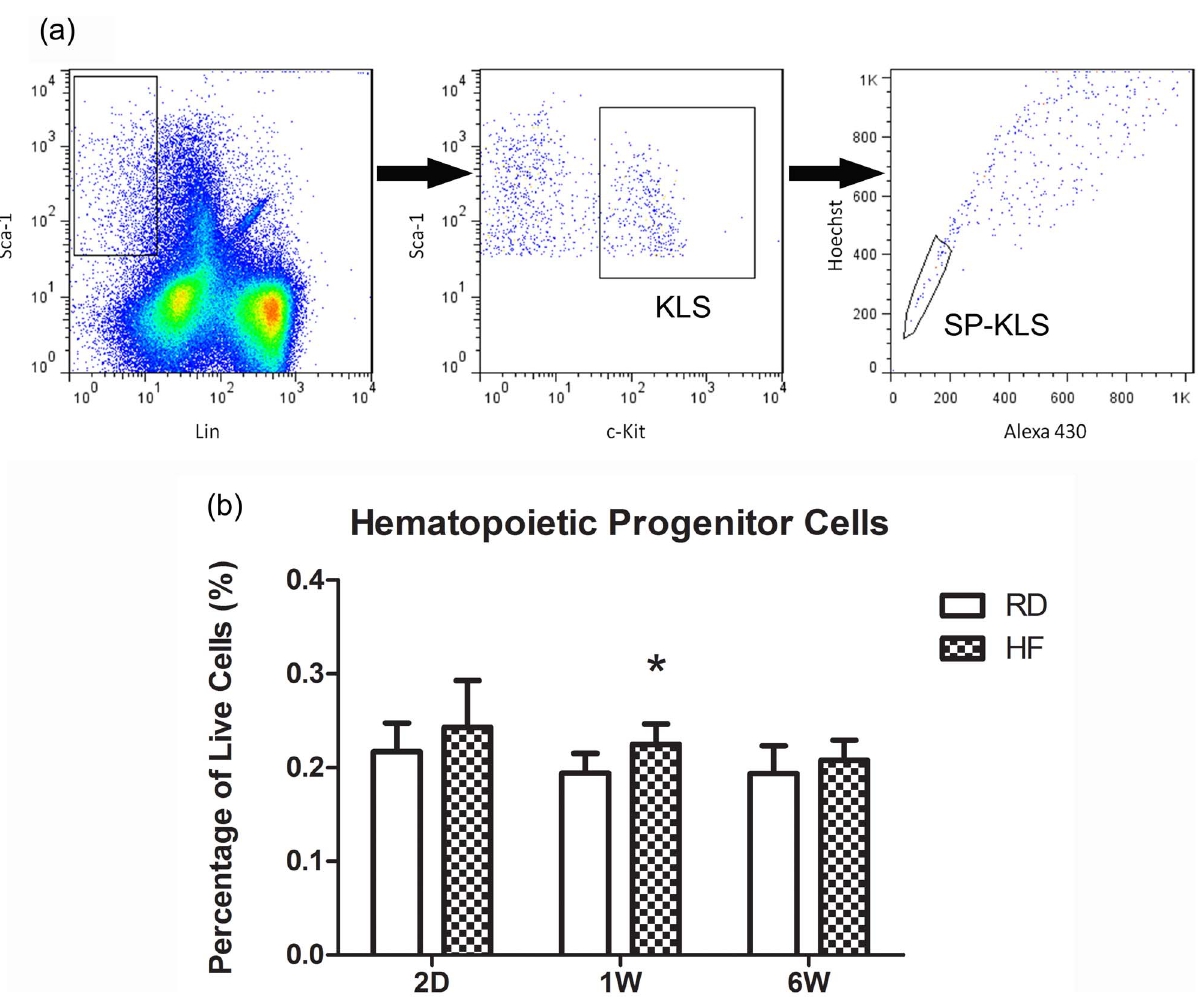
Figure 5. Hematopoietic Progenitors Rapidly Respond to High Fat Diet Mediated Damage. (a) A representative gating scheme to isolate KLS and SP-KLS cells is shown. HSCs (SP-KLS) were assessed to determine the hematopoietic response to obesity driven leukocyte mis-allocation but no differences were found at any time point studied. (b) Hematopoietic progenitors rapidly respond to obesity mediated damage displaying an early response to HFD with HF animals having elevated KLS populations at 1 week. By 6 weeks this response was no longer evident in HF animals. * P , 0.05 vs. RD.